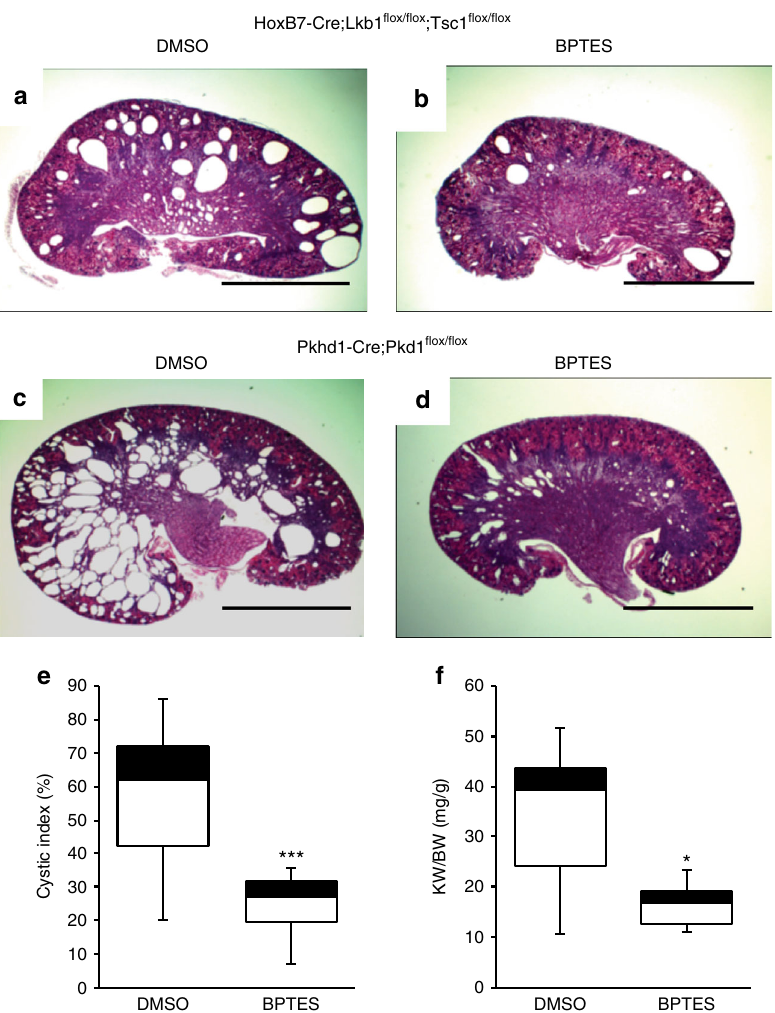
Fig. 6 Inhibition of glutamine metabolism slows cyst progression in vivo. Representative examples of H&E-stained sections from post-natal day 10 HoxB7- Cre; Lkb1 fl ox fl ox ; Tsc1 fl ox/ fl ox ( a , b ); and Pkhd1-Cre; Pkd1 fl ox/ fl ox ( c , d ) kidneys that were treated with 5% DMSO ( a , c ) or 100 mg kg -1 body weight of the glutaminase inhibitor, BPTES ( b , d ). Cystic indices for DMSO vs. BPTES-treated Pkhd1-Cre; Pkd1 fl ox/ fl ox kidneys show a signi fi cant reduction in the number of cysts in BPTES-treated animals ( e ). Kidney-to-body weight ratio of DMSO vs. BPTES-treated Pkhd1-Cre; Pkd1 fl ox/ fl ox kidneys ( f ). HoxB7-Cre; Lkb1 fl ox/ fl ox ; Tsc1 fl ox/ fl ox (DMSO-treated, n = 16; BPTES-treated, n = 16). Pkhd1-Cre; Pkd1 fl ox/ fl ox (DMSO-treated, n = 14; BPTES-treated, n = 14). Statistical analysis via Mann − Whitney U -test. * p < 0.05, *** p < 0.0001. Error bars shown as mean ± standard error of the mean (SEM). Scale bars equals 20